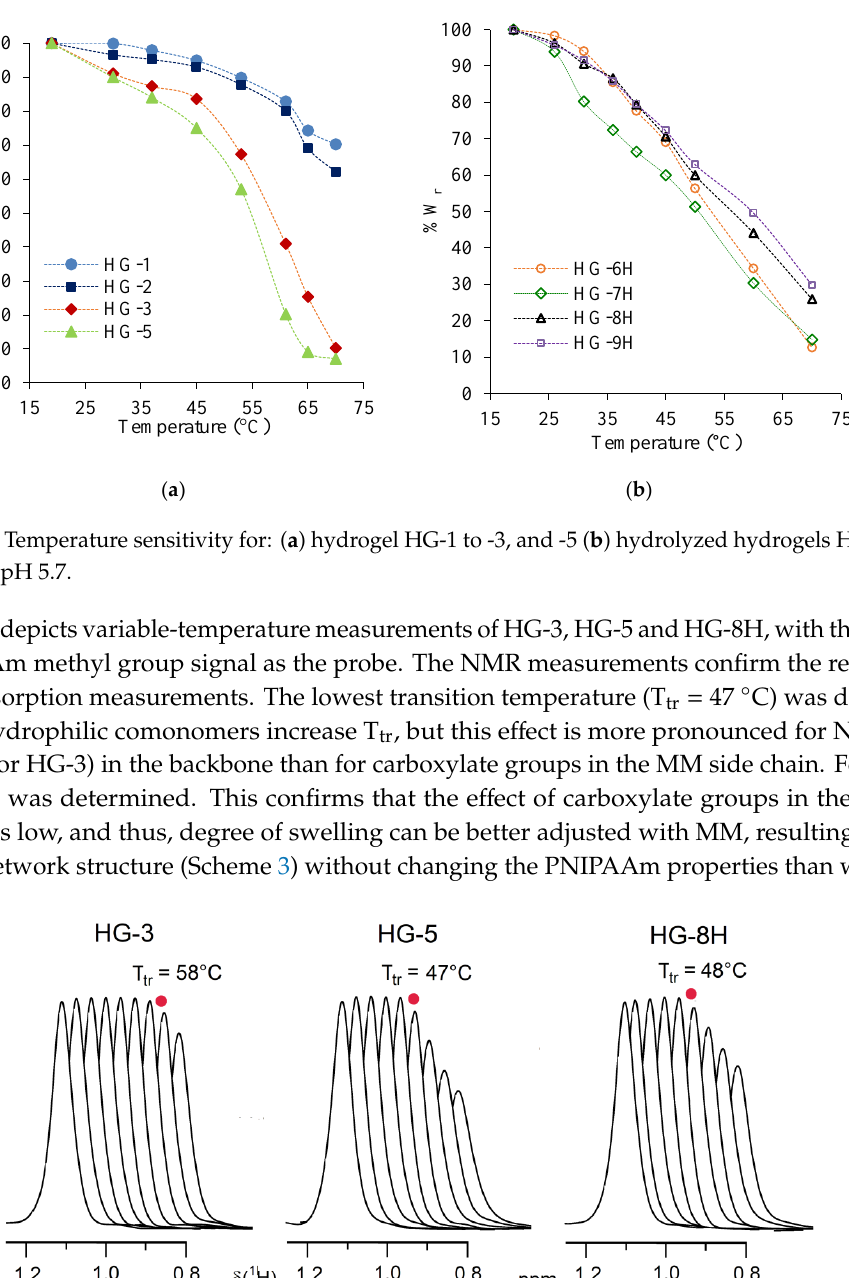
Figure 6. Stacked HR-MAS 1 H NMR spectra (signal of the NIPAAm methyl group, all referenced on the chemical shift at 25 °C: 1.12 ppm) at different temperatures (25, 30, 35, 40, 45, 50, 55, 60 and 65 °C) for hydrogels HG-3, HG-5 and HG-8H swollen in D 2 O with transition temperature T tr .